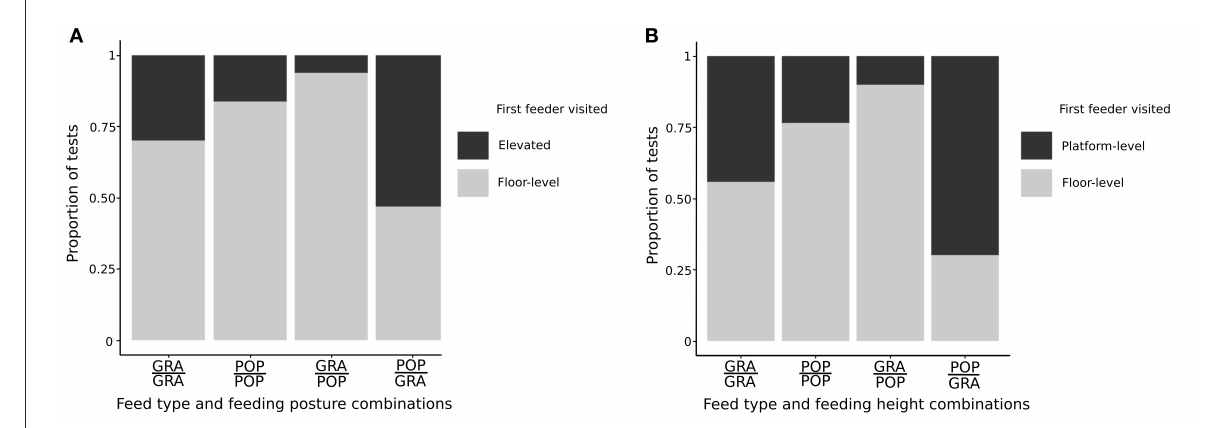
FIGURE6 First feeder visited expressed as a proportion of tests where visits were made ( n = 149), for each combination of feed type and feeding posture or height, for (A) Exp 1 (elevated feeder and floor-level feeder) and (B) Exp2 (platform-level feeder and floor-level